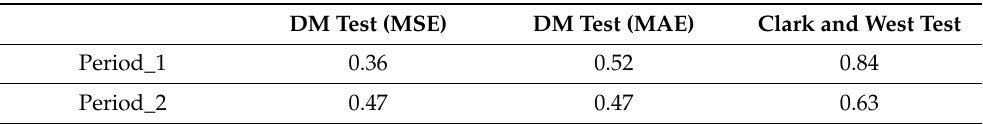
Table 10. D–M test and C–W test results on the significant difference between random forest regres- sion and LSTM. DM Test (MSE) DM Test (MAE) Clark and West Test Period_1 0.36 0.52 0.84 Period_2 0.47 0.47 0.63